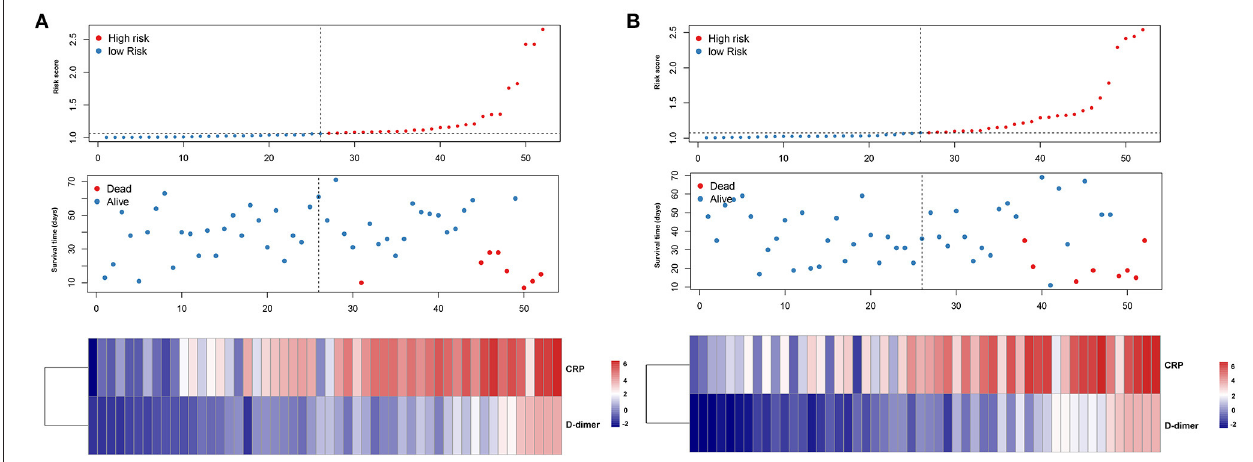
FIGURE 6 | Characteristics of prognostic indicator signature in the training dataset (A) and testing dataset (B) , respectively. The upper panel showed the risk score distribution of the prognostic signature, the middle panel represent the patients distribution, and the lower panel represent the level of the two prognostic indicators.